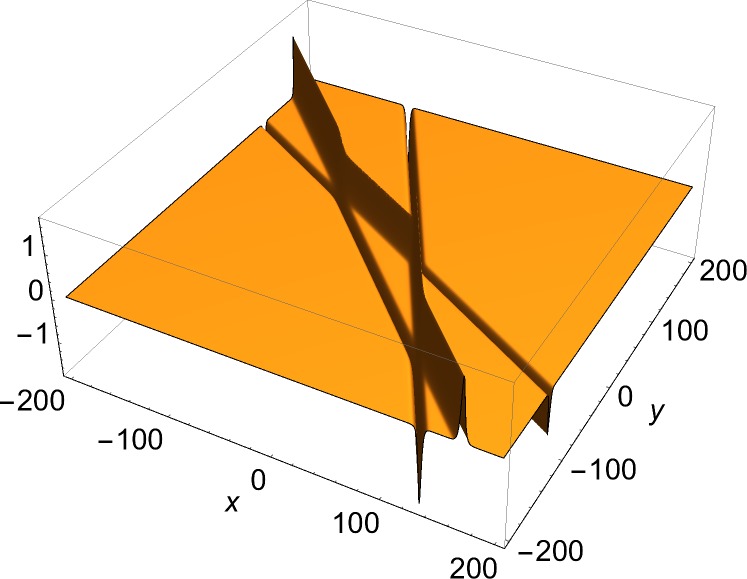

x-component of current density (Eq (9)) of three-front solution.
φ
1 = π/6, φ
2 = π/3, φ
3 = π/4, δ
1 = 20, δ
2 = 0, δ
3 = -20.